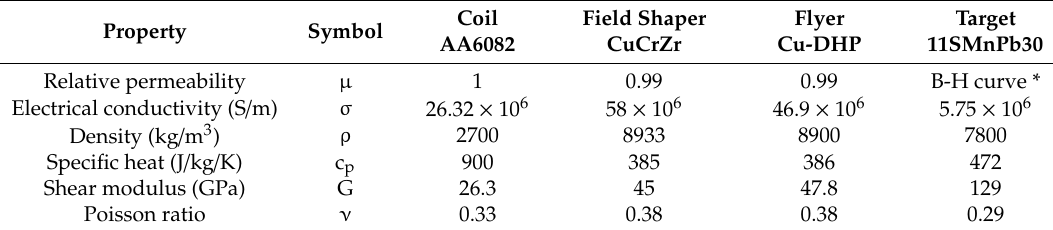
Table 2. Material properties of coil, field shaper and tubes (flyer-target) [10].